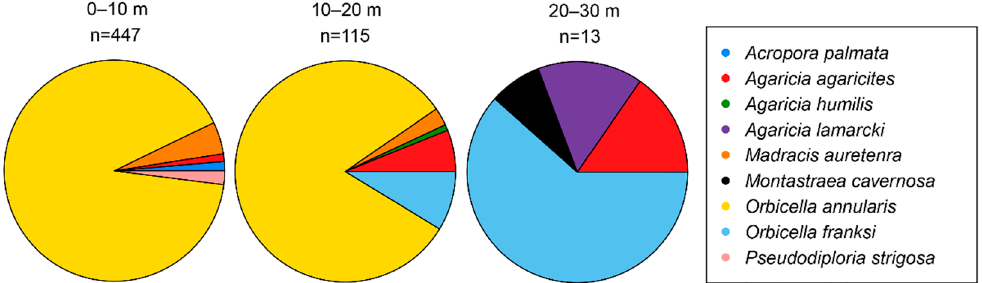
Figure 7. Host utilization by Coralliophila galea in three depth ranges.